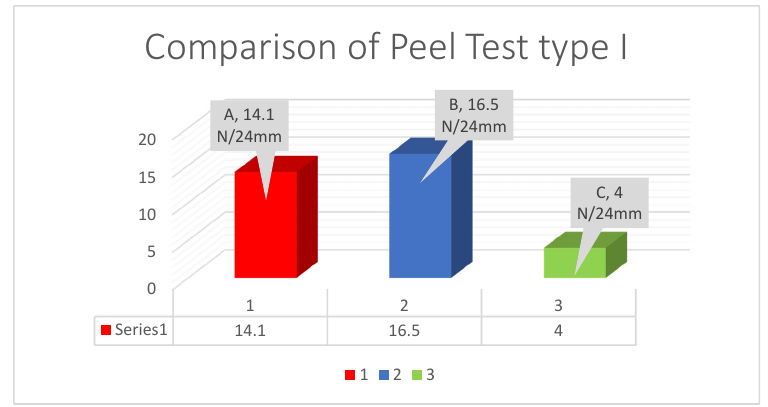
Figure 7. Comparison values of the peel test of type I specimens A, B, and C. Coatings 2021 , 11 , x FOR PEER REVIEW Type II: When Glass Fabric is Clamped on the Upper Jaw and Kevlar is Clamped on the Lower Jaw for Debonding Kevlar fabric is clamped on the lower, fixed jaw and glass fabric is clamped on the upper, movable jaw to check the adhesion between the glass fabric and Kevlar by peeling them apart completely. Peel test examination of type II shown in Figure 8.